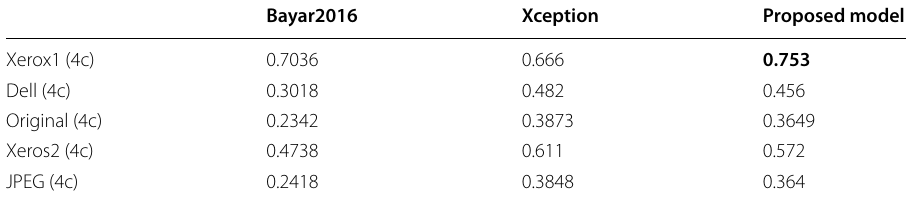
Table 4 Validation accuracy for various validation sets after training on Xerox1 data set (see Table 2,